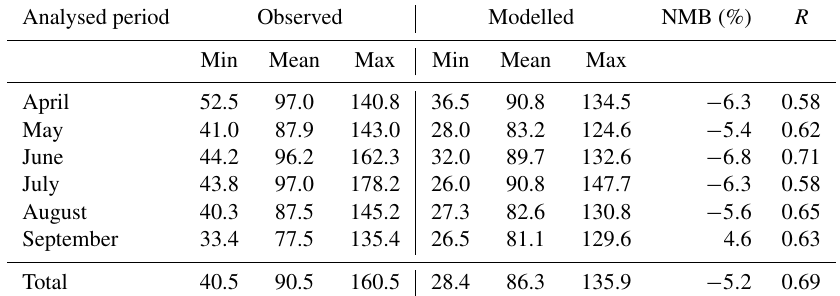
Table 3. Observed mean and simulation summary statistics for MDA8 O 3 concentrations (µgm − 3 ) at rural background sites. The normalised mean bias (NMB) and correlation coefficient ( R ) are calculated between simulated and observed O 3 concentrations from the AirBase dataset